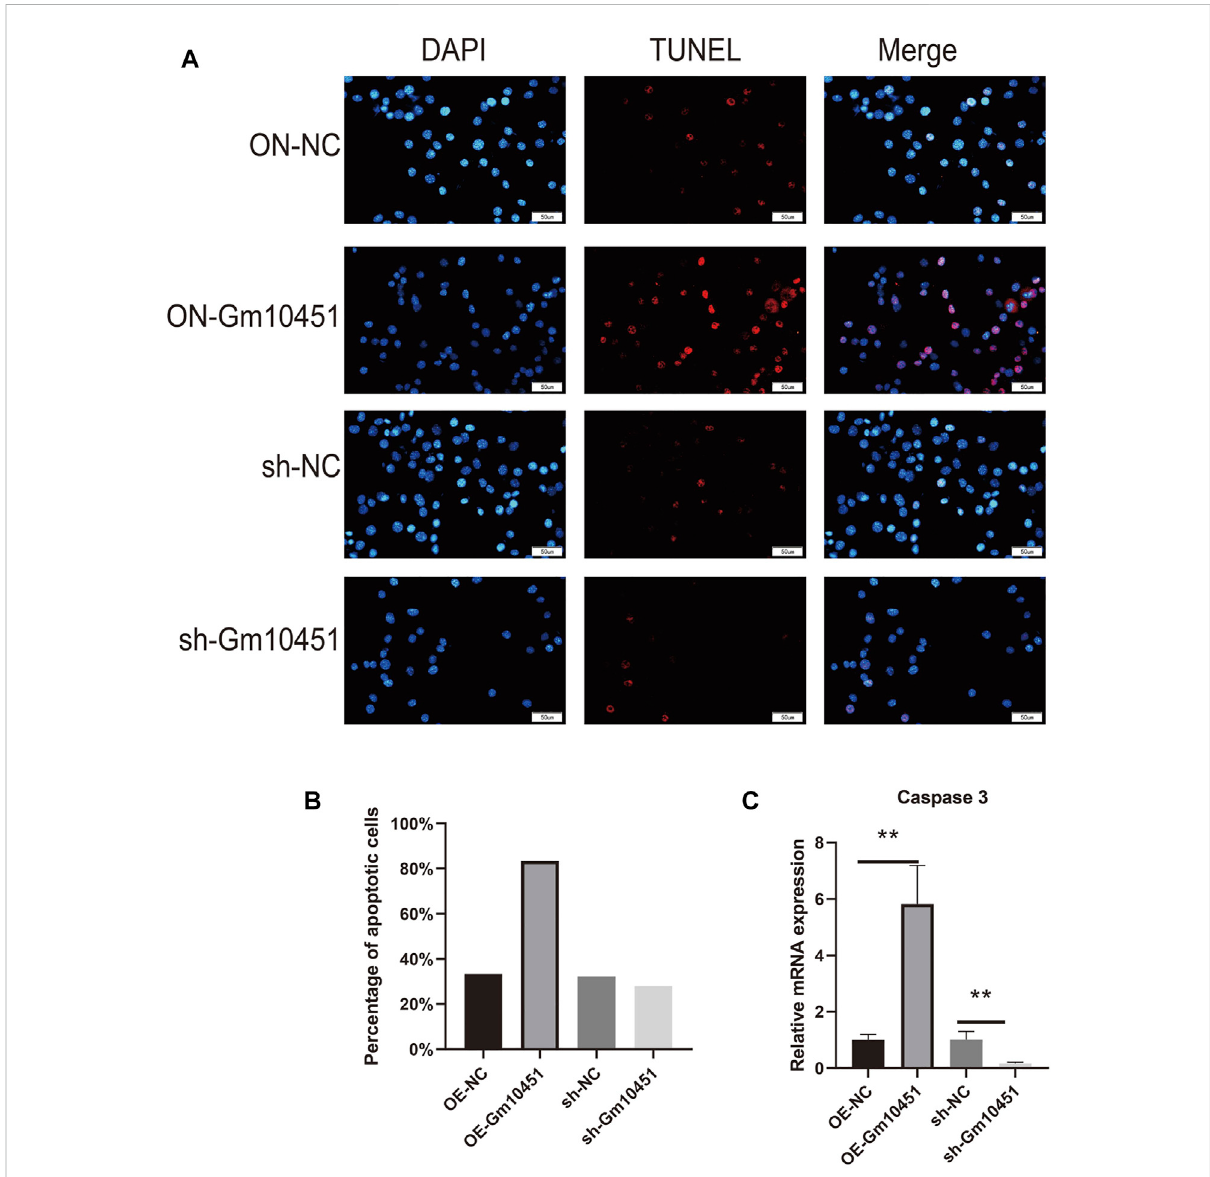
temperature for 30 min, with which the MIN6 cells were cultured in a 5% CO 2 incubator. qPCR assay The total RNA was extracted from MIN6 islet cells, using the TRIzol reagent, and cDNA reverse transcription was performed according to the kit instructions (TaKaRa, Japan). The